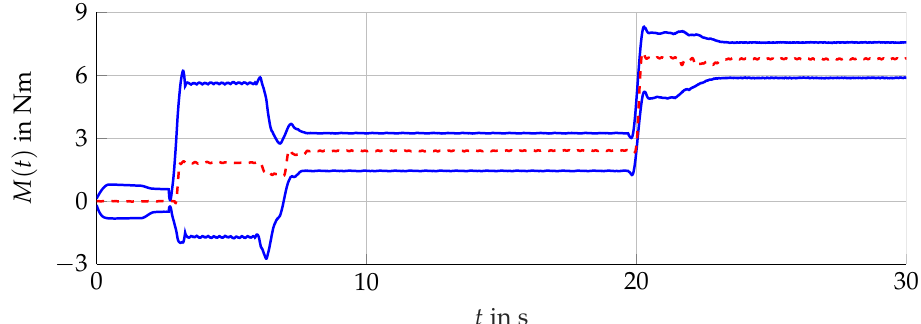
Figure 15. Torque interval boundaries M ( t ) and M ( t ) (blue, solid) calculated with i µ , α ( t ) and i µ , α ( t ) of B (see Figure 14) compared with the measured torque M mv ( t ) (red, dashed).